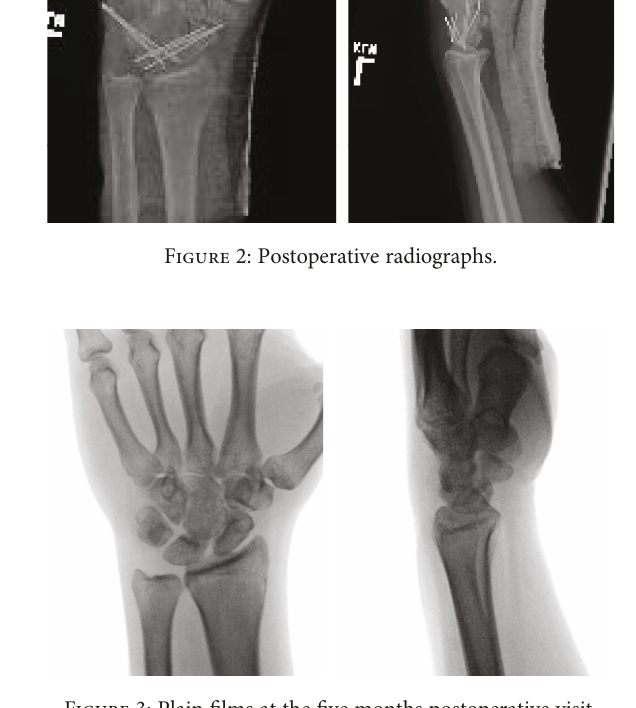
Figure 3: Plain fi lms at the fi ve months postoperative